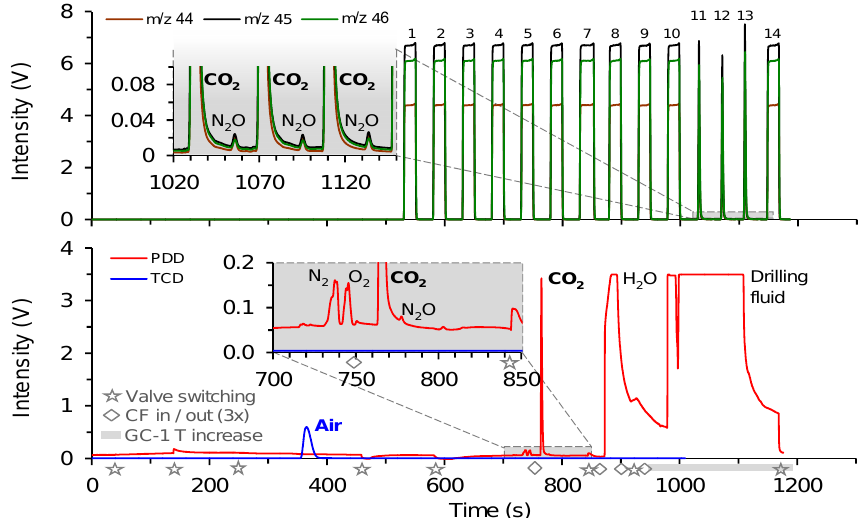
Figure 3. Chromatograms for the measurement of an ice sample as described in Sect. 3.2. Upper panel: IRMS signal intensity for m/z 44, 45 and 46. Injections of the WS via the open split are identifiable by the flat-topped peaks. Peaks 1–9 are used to reach stable source conditions while peaks 10 and 14 before and after the samples are used for referencing. The inset shows baseline details and N 2 O separation in detail. Lower panel: PDD and TCD intensity signal for CO 2 and air, respectively. Stars indicate valve switching, resulting in small variations in the PDD signal due to changes in pressure and flow (see inset, not detected by the less sensitive TCD). Diamonds indicate immersion of the three capillary traps into liquid nitrogen for CO 2 cryofocusing and their subsequent one-by-one release resulting in the three peaks of the split sample shown in the upper panel (peaks 11–13). Over the time period, indicated by the grey bar, the GC–1 temperature is increased to 150 ◦ C in order to precondition the column for the next sample (release of water and remnants of drilling fluid contamination). The enlargement shows baseline details revealing the N 2 O peak and small remains of N 2 and O 2 from the air sample, incompletely separated by the preceding cryogenic